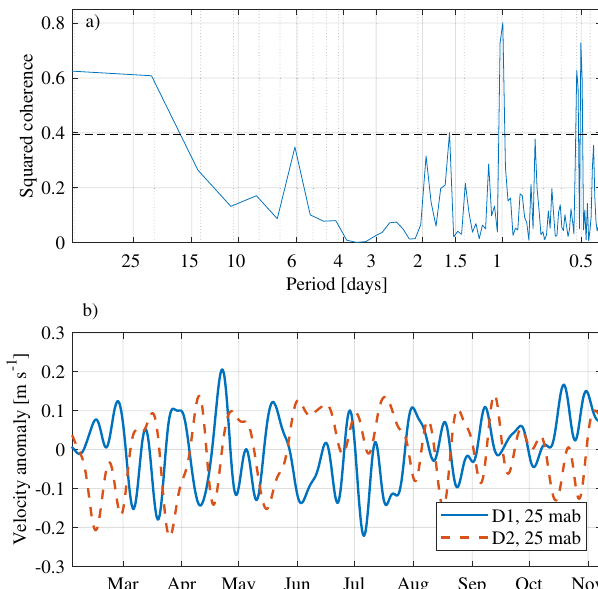
Fig. 2 | Observed cross-isobath velocities. a Squared coherence between the D1 and D2 (25 meters above bottom, mab) current component aligned with the mean current at D1, see Fig. 1d. The dashed black line shows the 95% con fi dence level. b 10-day low-passed time series of velocity anomalies (same component as in a ) from D1 and D2 (25